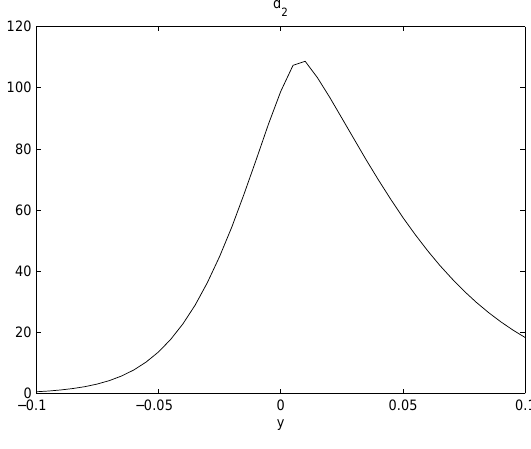
Figure 22. Excessive demand d 2 ( y ) as a function of